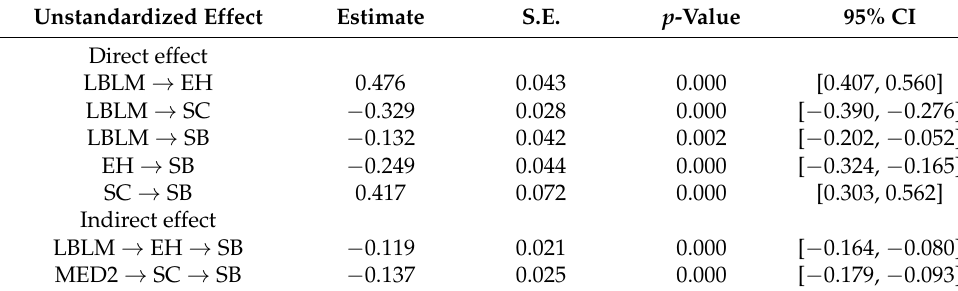
Table 5. Direct effect and indirect effect results (N =